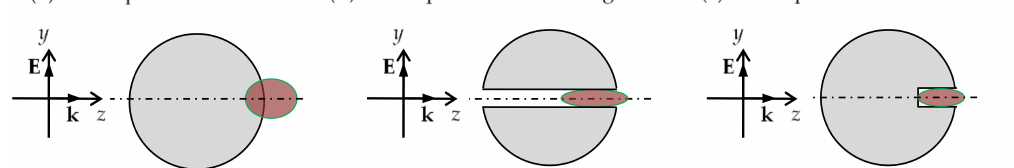
Figure 1. Schematic diagrams for the simulated dielectric sphere ( a ) without a nanohole, ( b ) with a through hole, and ( c ) with a blind hole. The incident light is a plan wave that propagates along the z-axis, k is the wave vector. The incident field E is polarized along the y-axis. The oval-shaped zones in dark red color indicate the focal spots, and dash-dotted lines indicate the symmetrical axes for the